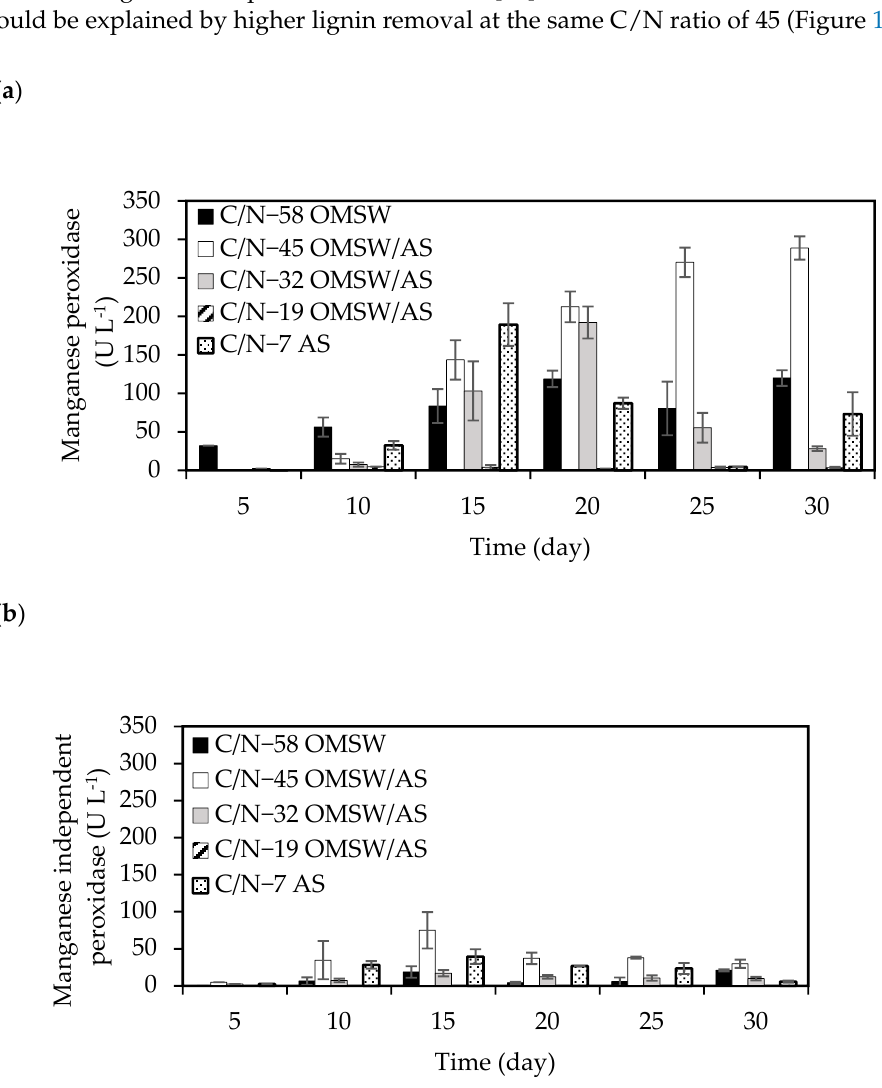
Figure 2. Time evolution of enzyme activity; manganese peroxidase ( a ) and manganese independent peroxidase ( b ), in the pre-treatment of OMSW and AS with A. discolor at different C/N ratios.